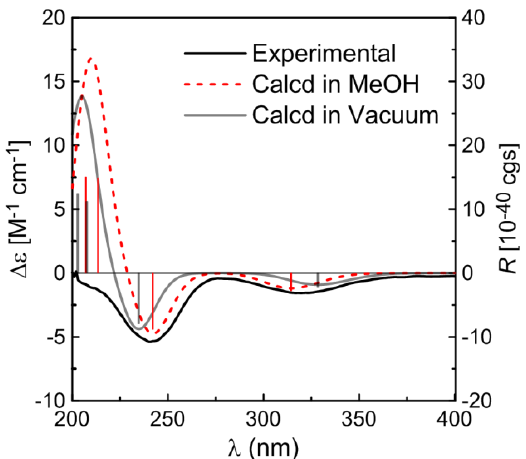
Figure 3. Calculated CD spectra of compound 1 in MeOH solution (red) and in vacuum (gray) and comparison between the calculated and experimental CD (black) spectra. Vertical bars represent rotational strengths R . σ = 0.20